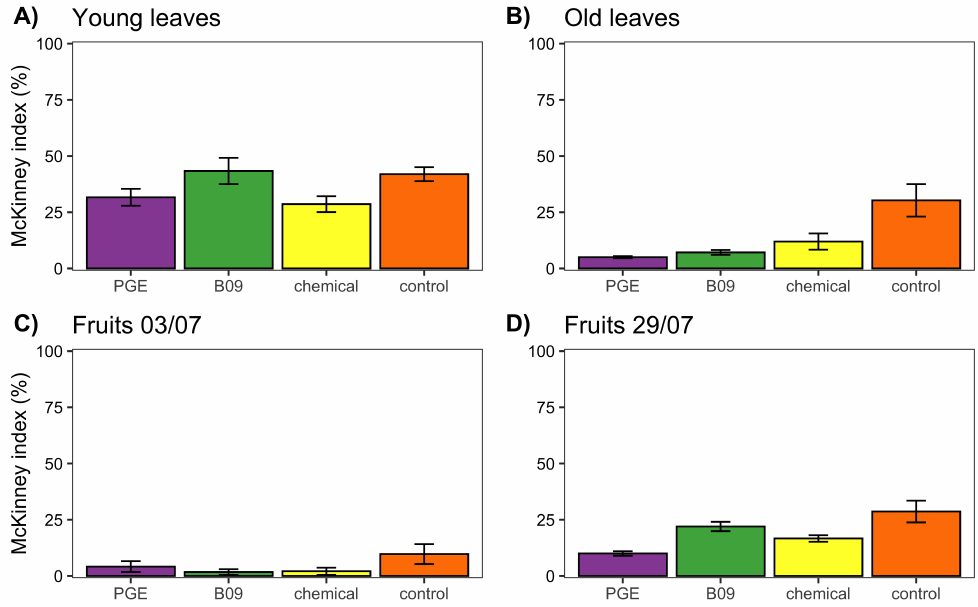
Figure 3. Efficacy of an alcoholic extract from the bacterial isolate B09 in reducing the incidence and severity (both accounted for using McKinney’s index) of the damage caused by powdery mildew on grapes in field conditions. The extract is compared to a plant extract with strong antifungal activity (pomegranate peel extract, PGE), the chemical treatments that are normally performed in the farm, and an untreated control